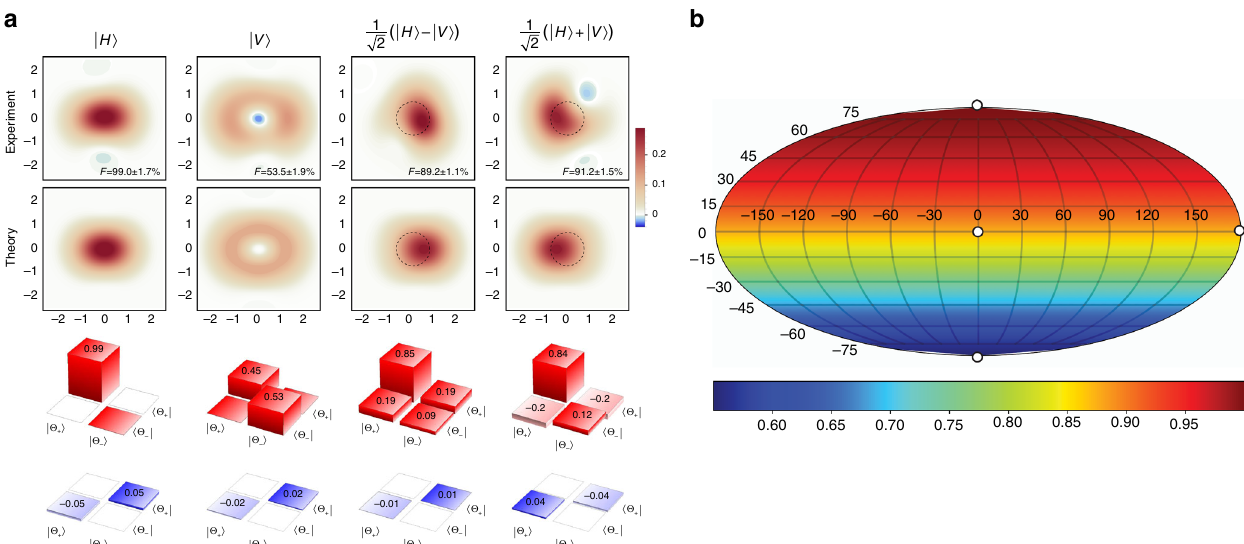
Fig. 3 Results of the teleportation from a polarization qubit in mode B onto a CV qubit in mode C. a Wigner functions and density matrices of the teleported states for four input polarization states [same notation as in Fig. 2, the fi delities are calculated with respect to the theoretically expected superpositions Eq. (5) of cat states]. Theoretical Wigner functions are calculated according to Eq. (6). b Teleportation fi delity based on the theoretical model Eq. (6) which agrees well with the experimental results in a , calculated for the entire Bloch sphere. The white dots represent the input states of the teleportation